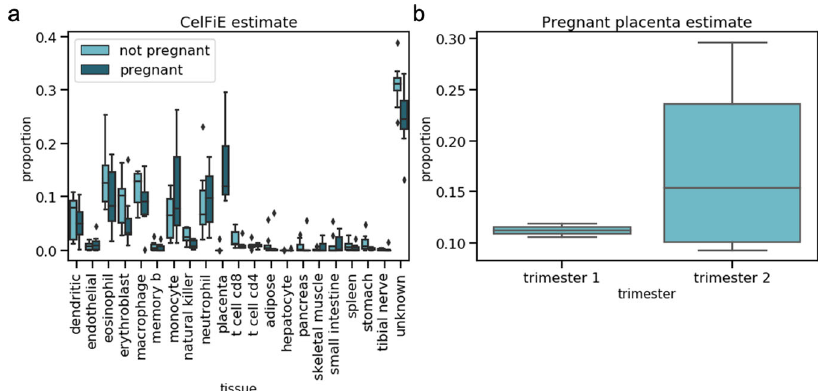
Fig. 7 Decomposition estimates for cfDNA derived from pregnant women and non-pregnant controls. a CelFiE decomposition estimates for independent samples of n = 8 non-pregnant (light blue) and n = 7 pregnant women (dark blue). b CelFiE placenta estimates for n = 3 pregnant women in the fi rst trimester and n = 4 women in the second trimester. In all cases, the center line of the boxplot indicates the mean, the outer edges of the box indicate the upper and lower quartiles, and the whiskers indicate the maxima and minima of the